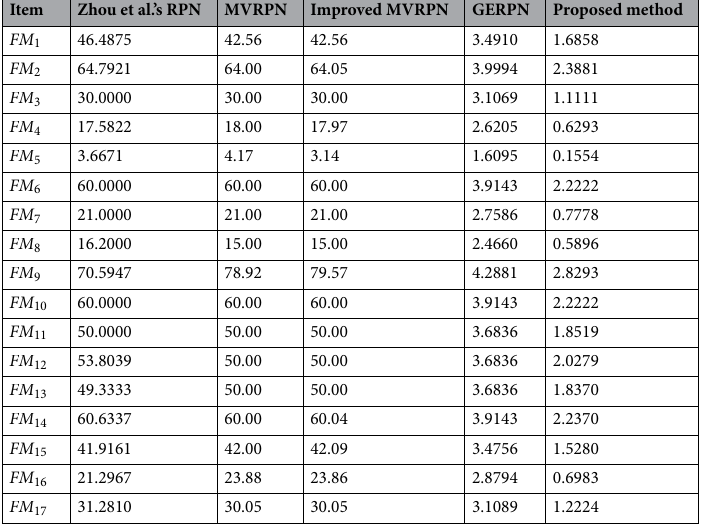
Table 11. A comparison of RPN